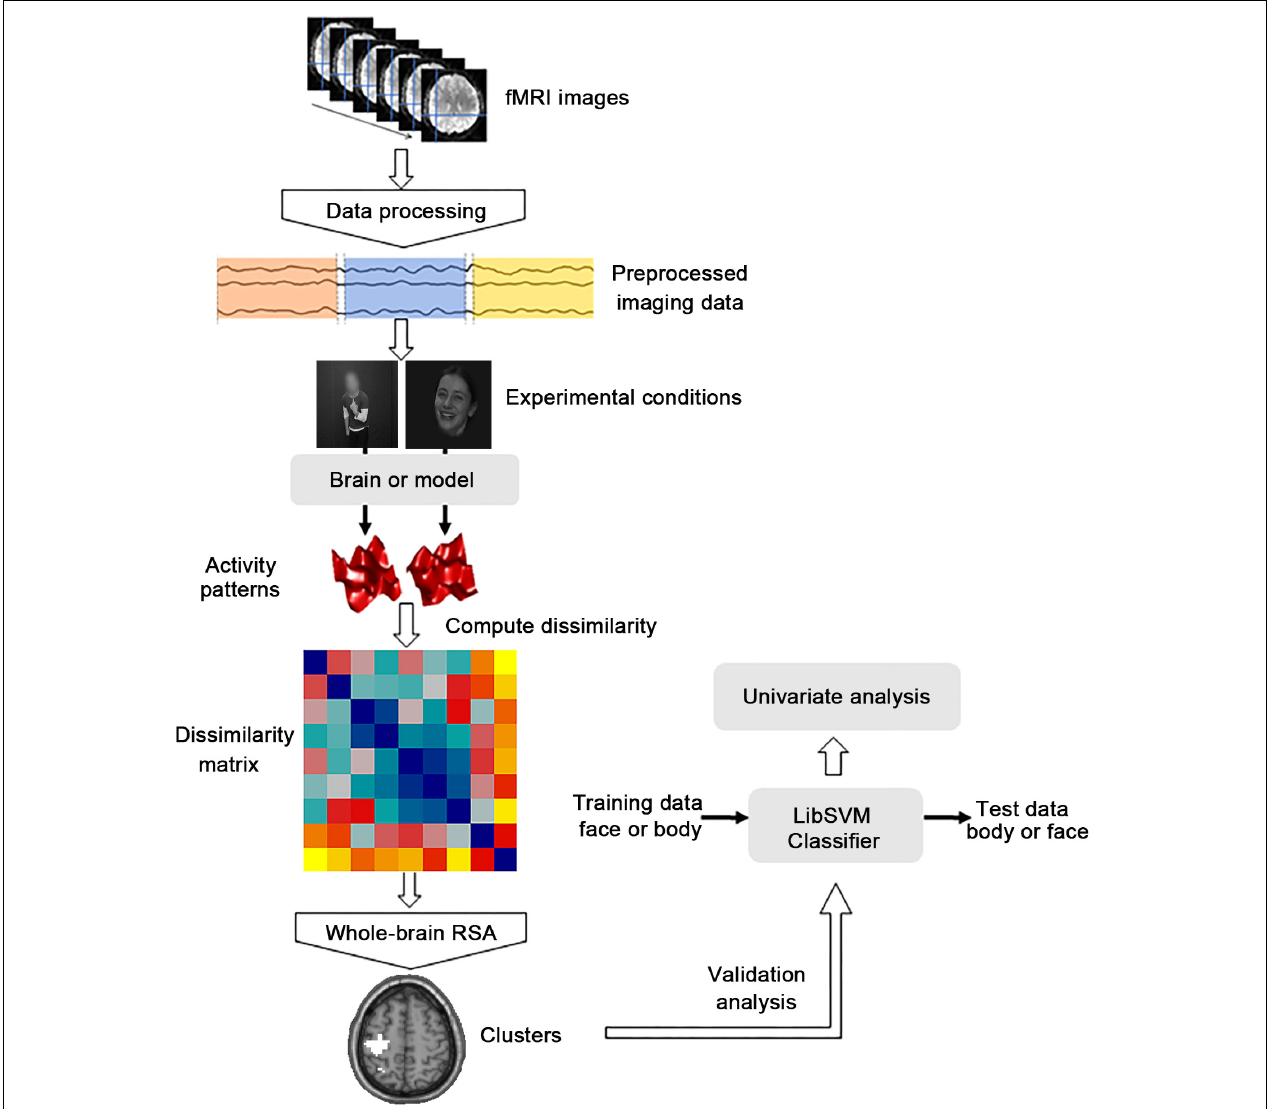
FIGURE 2 | Flow chart of the main analytical steps. There were three kinds of main procedures. The dissimilarity matrix was first established for the abstract emotion model and then the representational similarity analysis (RSA) was performed to calculate the correlations between the dissimilarity matrix capturing the model and the neural dissimilarity matrix of each voxel across the whole brain. Then the cross-modal multivoxel pattern analysis (MVPA) was performed as the additional validation analysis to verify whether the clusters identified by whole-brain RSA were truly informative to abstract representations of emotions. A further univariate analysis was then conducted to explore the differences between the mean activation patterns of the significant clusters identified from the MVPA procedure.